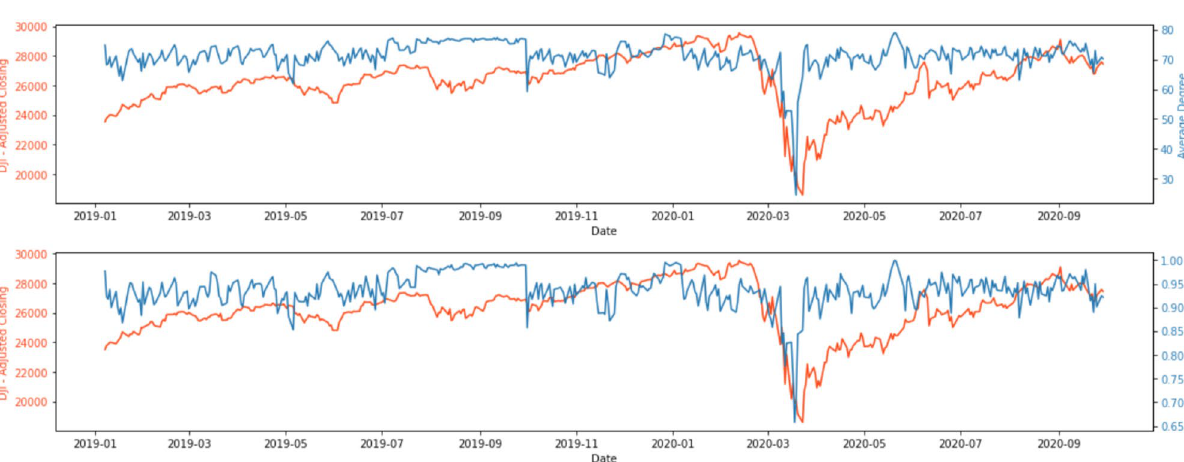
Figure 6. Comparison of network statistics with DJIA, 1 January 2015 to 31 December 2016.